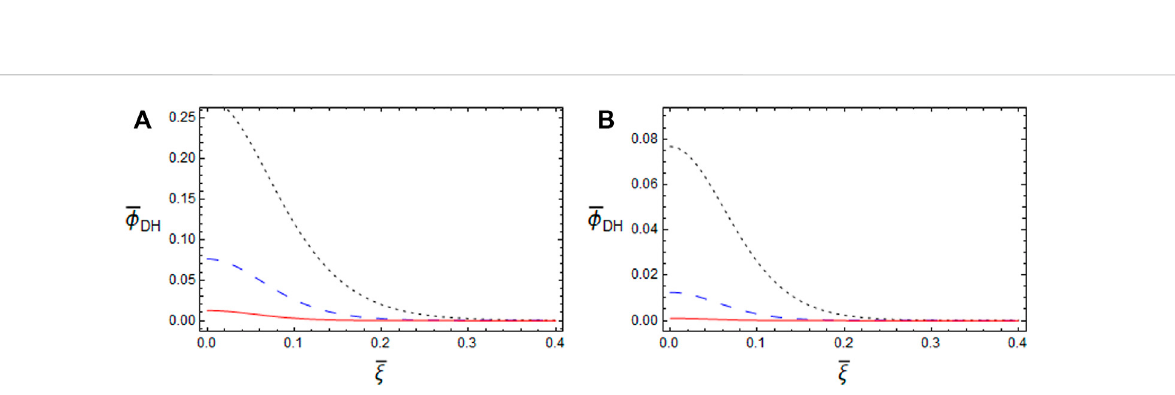
FIGURE 3 The variation of DH potential ( (cid:2) ϕ DH ) is displayed against the normalized axial distance ( (cid:2) ξ ) for changing dust polarization coef fi cient ( R ) at low and high charging states (A) z d 0 = 3500 and (B) z d 0 = 5000 with (cid:2) ρ (cid:1) 0 . 15. All other parameters are the same as given in Section 3.